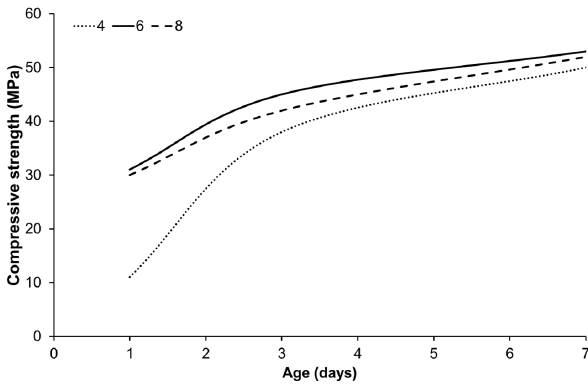
Figure 8: Effect of SH concentration on early age compressive strength of SC activated slag (adapted from [38])